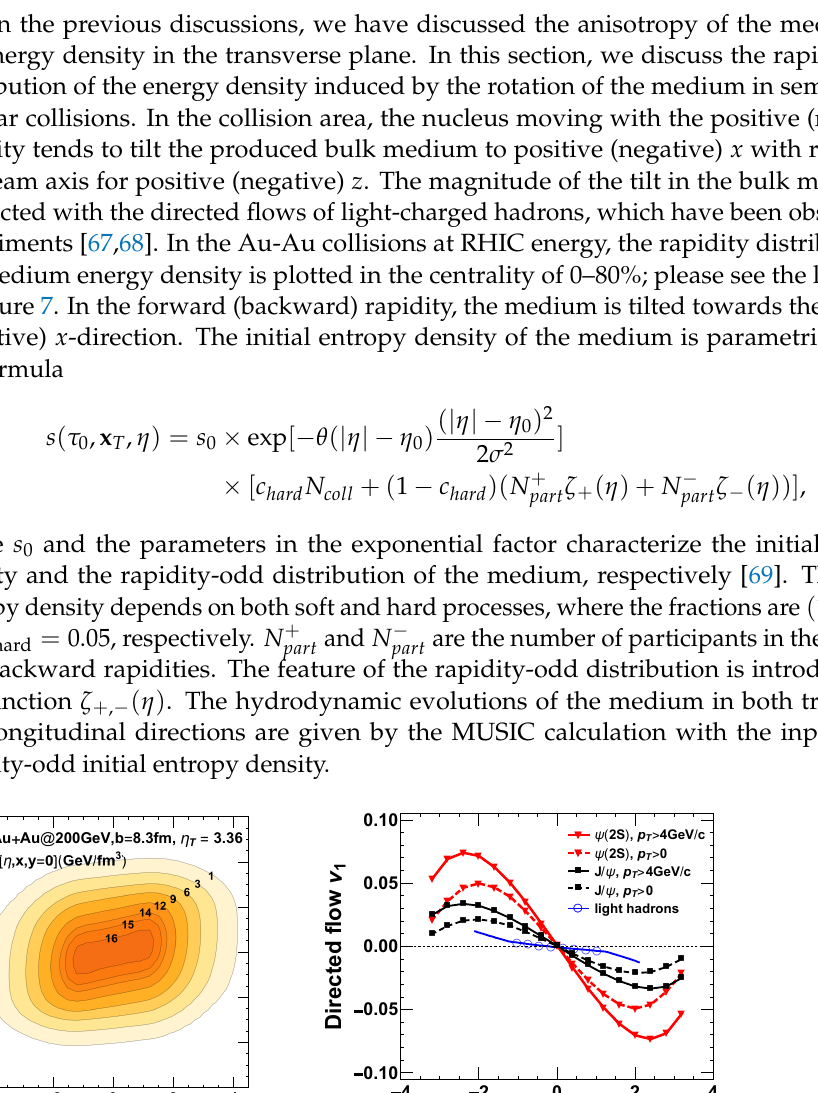
Figure 7. ( Left ) Rapidity-odd distribution of initial entropy density in collisions. The collision centrality is 0–80%, corresponding to the averaged impact parameter b = 8.3 fm. ( Right ) The directed flows of J / ψ and ψ ( 2 S ) as a function of rapidity η . Different p T bins ( p T > 0 and p T > 4 GeV/c) are calculated. This figure is cited from Ref.